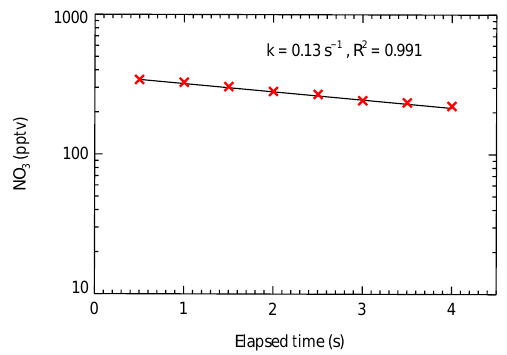
Figure 7. The determined concentration decay of the NO 3 radical in the heated detection cell caused by the wall loss. The red crosses denote the observation results, and the black line depicts the cor- responding exponential fit. The net wall loss reactivity of NO 3 is corrected to be 0.16 ± 0.02s − 1 with a box model simulation of the chemical reactions occurring in the detection